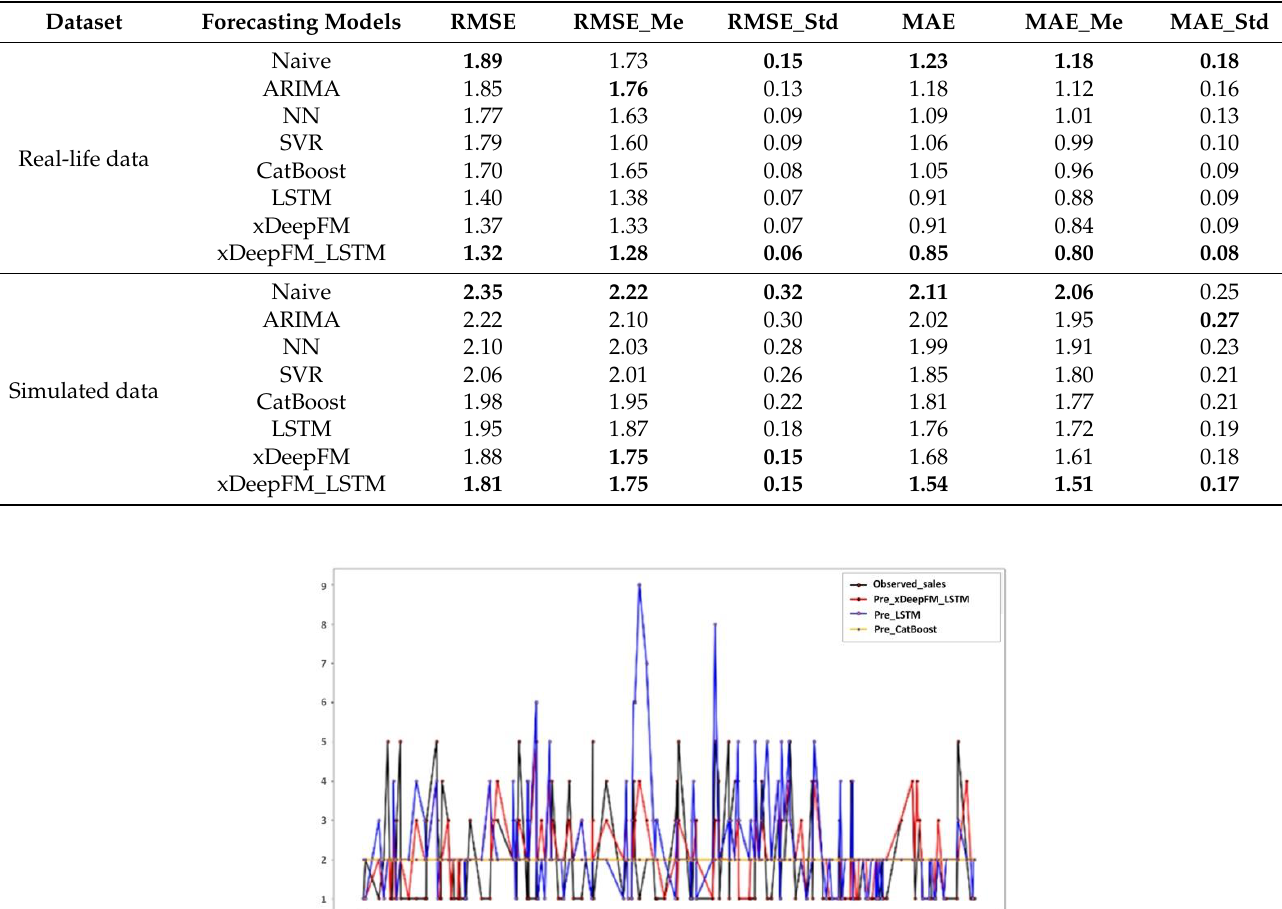
Table 2. Comparison of error values for each model under real-life and simulated data.